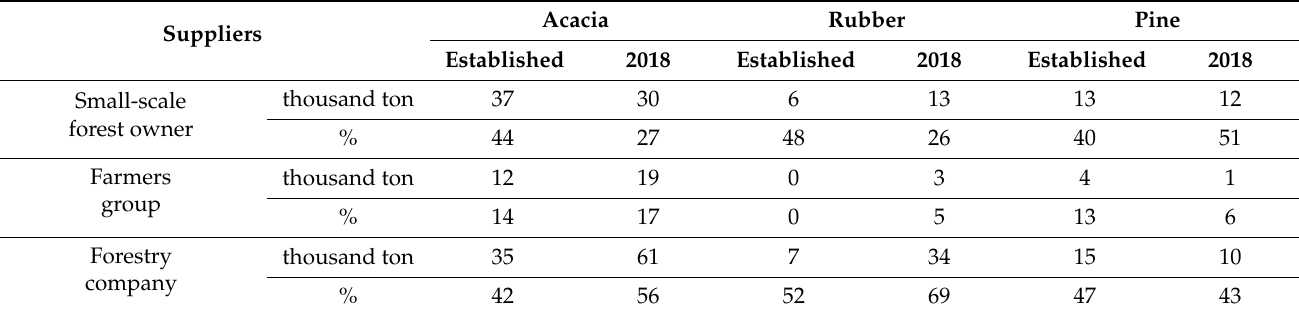
Table 5. Changes in the amount and proportion of timber by supplier in Quang Tri